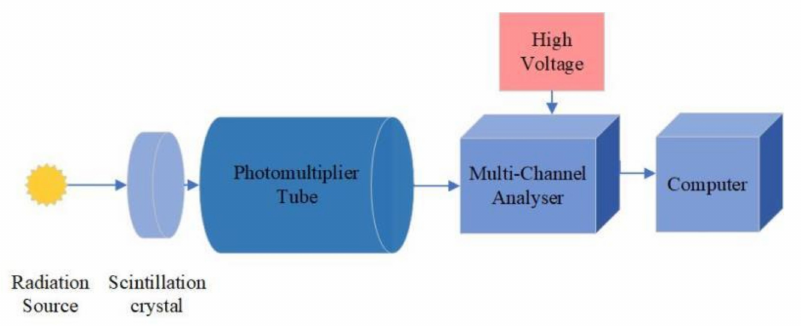
Figure 2. Experimental Setup.